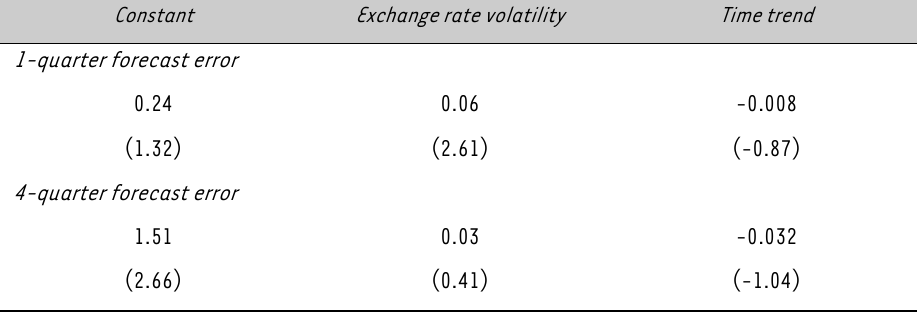
TABLE 7: Inflation forecast errors and exchange rate volatility, 2000-2006 Constant Exchange rate volatility Time trend